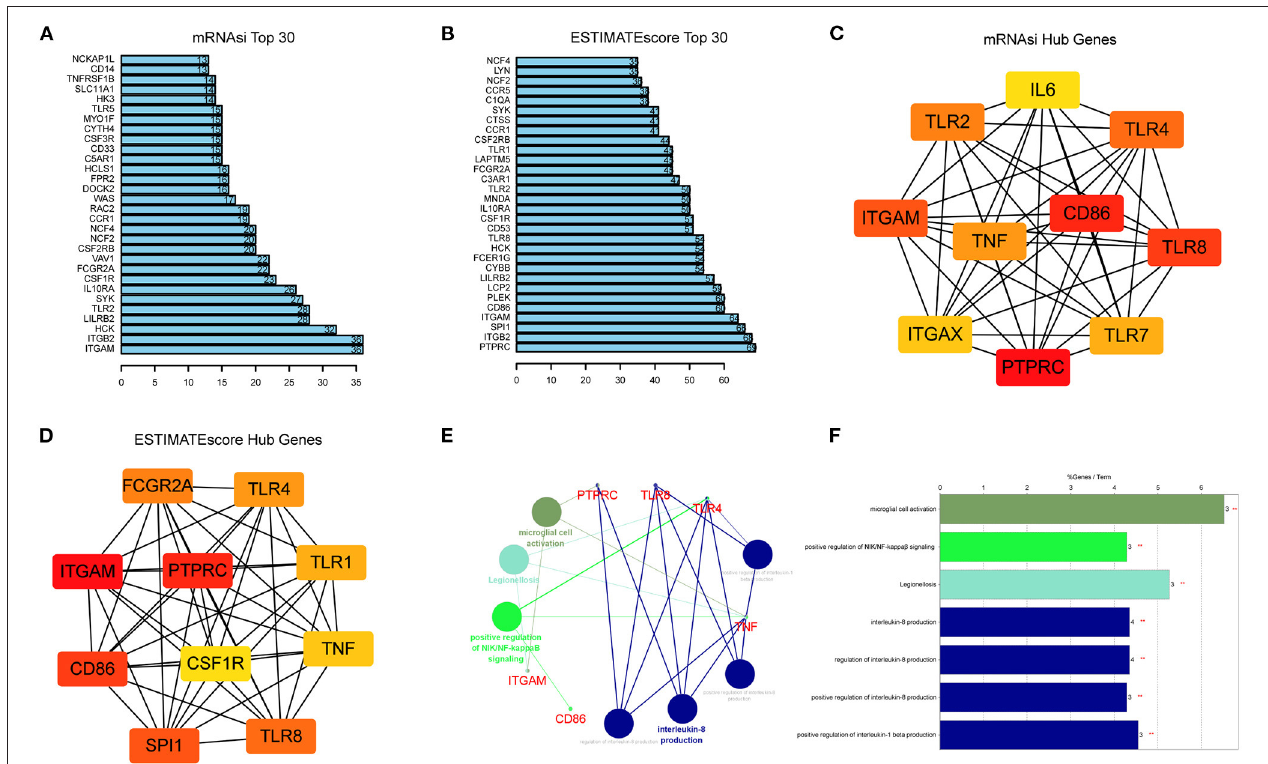
FIGURE 5 | Identification of hub genes from the PPI network. (A,B) PPI network obtained using STRING and showing the top 30 highest scoring genes. The bar plots of top 30 key genes of mRNAsi (A) and ESTIMATEScore (B) . (C,D) Top 10 hub genes of mRNAsi (C) and ESTIMATEScore (D) explored by CytoHubba algorithm in Cytoscape software 3.8.0. and red nodes represent hub genes. (E,F) KEGG pathway and GO analysis of five overlapping genes (TLR4, TLR8, TNF, CD86, ITGAM, and PTPRC) using the “ClueGO” and “CluePedia” plugins ( p <